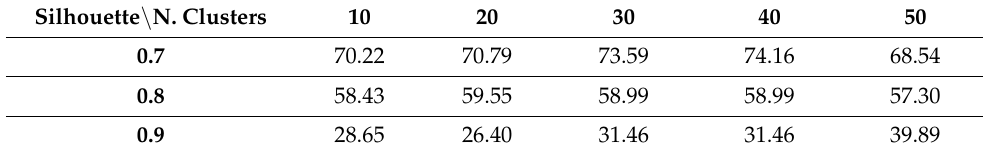
Table 26. Clustering performance in terms of silhouettes using the reduced dataset with PCA. Silhouette \ N. Clusters